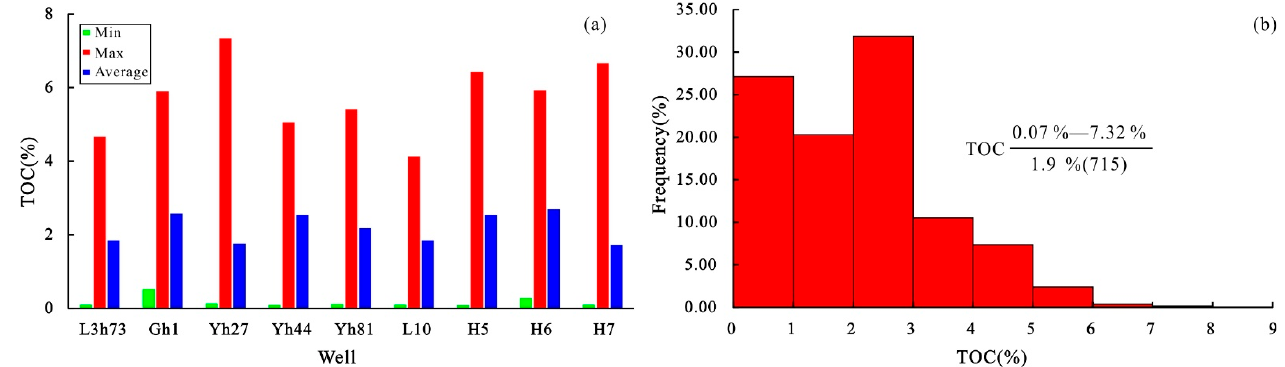
Figure 3. TOC frequency distribution histogram of the study area: ( a ) TOC distribution characteristics of different drilling wells; ( b ) TOC frequency distribution histogram. Table 3. TOC statistics of different wells in the study area.